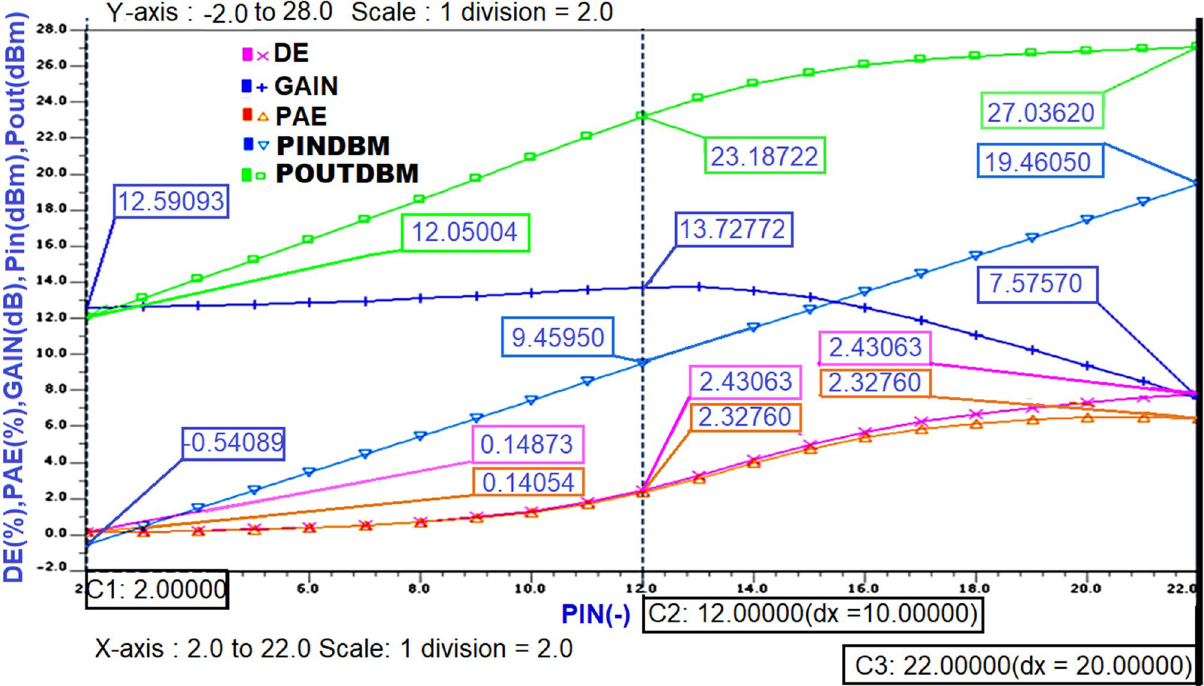
Figure 22. The performance parameters of Class-J PA with RF input at 5 GHz.